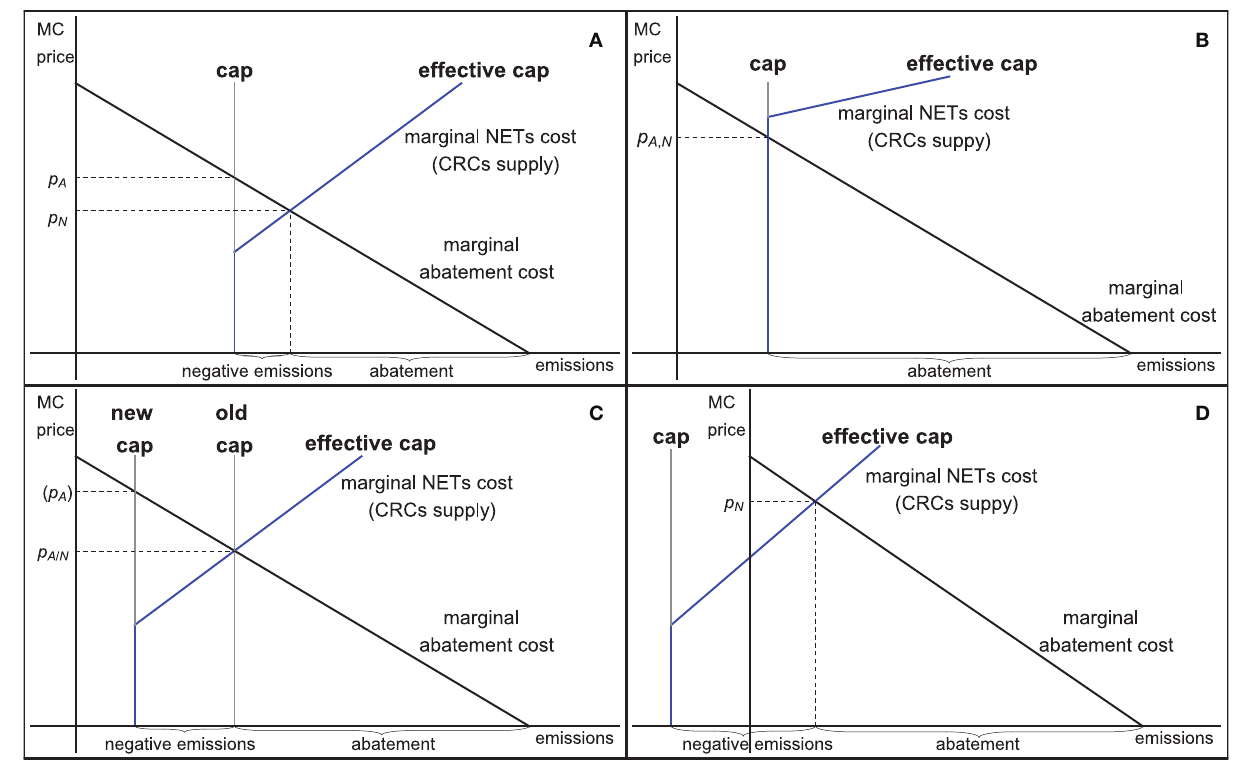
FIGURE 1 | Integration of CO 2 removal credits from Negative Emissions Technologies. Panel (A) shows the integration of competitive NETs without adjusting the regulatory cap and p A and p N indicate the prices observed with emissions reductions via abatement only and with negative emissions integrated, respectively, (B) shows the integration of non-competitive NETs, (C) shows the integration of competitive NETs with adjusting the regulatory cap such that the allowance price remains unchanged, and (D) shows the integration of NETs for a negative